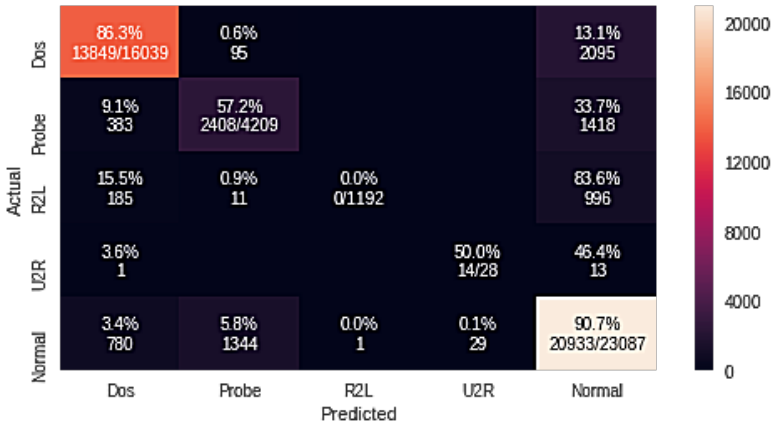
Figure 9. Naive Bayes confusion